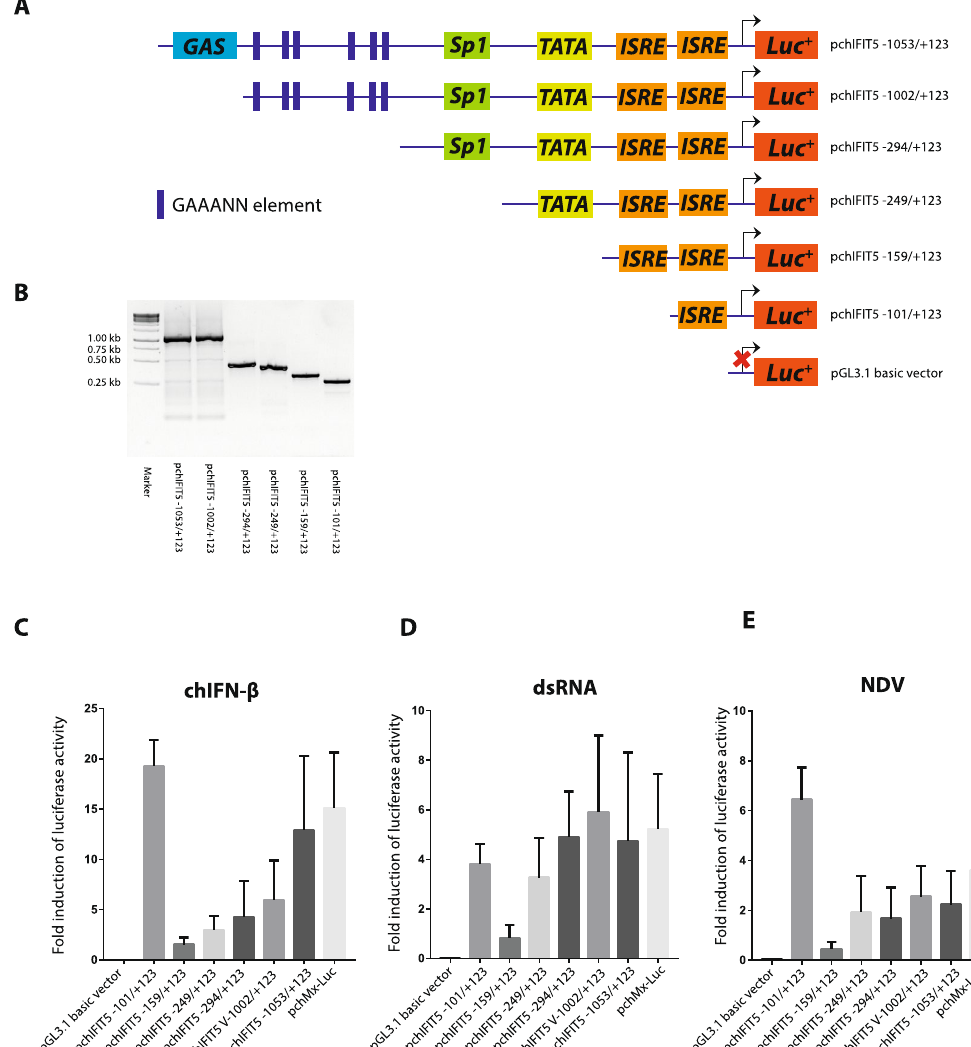
Figure 3. Promoter architecture and functional validation of chIFIT5 promoter responsiveness to chIFN- β , dsRNA and NDV. ( A ) Schematic presentation of full-length chIFIT5 promoter and subsequent construction of five truncated mutant constructs. ( B ) Shown are lengths of six total constructs upstream to firefly luciferase gene. ( C–E ) DF-1 cells were co-transfected with 150 ng of each of these chIFIT5 promoter-constructs along with 50 ng of pRenilla luciferase (loading control) for 24 hours and were stimulated with 1000 U/ml of chIFN- β ( C ), 5 ug/mL of dsRNA ( D ) or 1 MOI of NDV ( E ) for another 24 hours. Fold induction of firefly luciferase activities were measured and were normalized to Renilla luciferase. Data on viral and non-viral responsiveness of chIFIT5 promoter is average of three independent